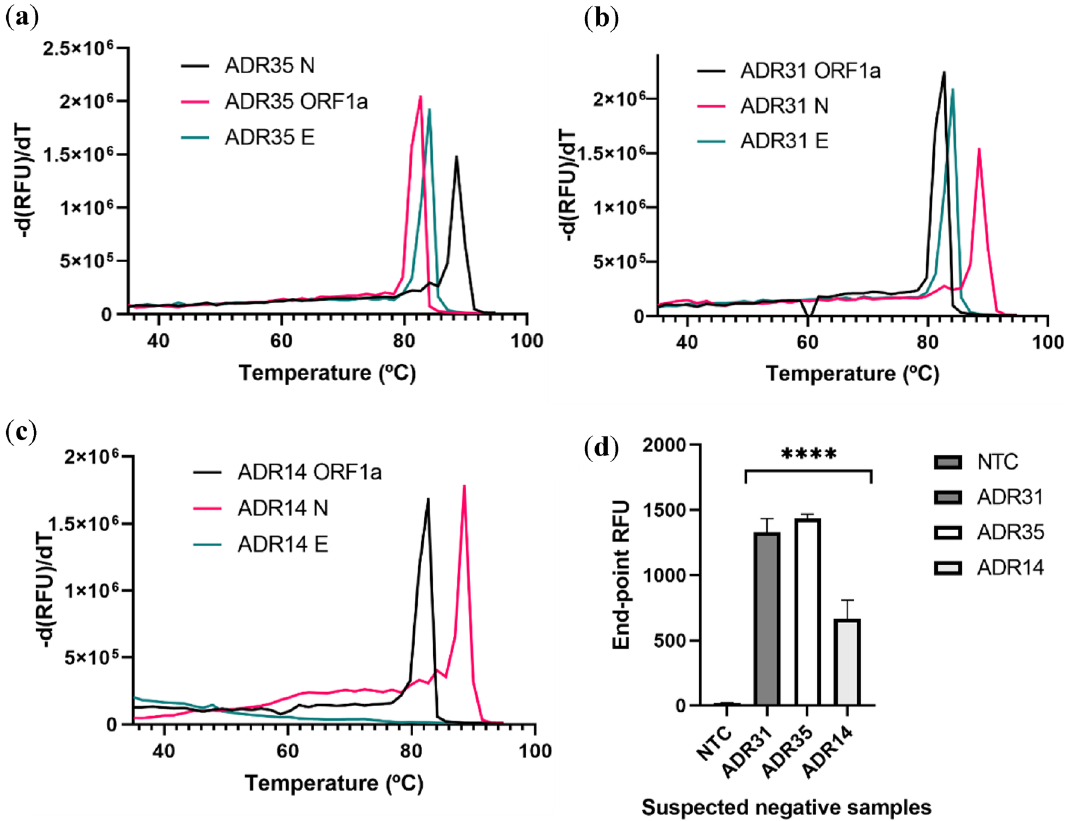
Figure 6. Melting curve analysis from the RT-LAMP reaction of clinical samples. Samples that were considered SARS-CoV-2 positive by INSA were further analysed. Melting curve for sample ADR35 ( a ), ADR31 ( b ) and ADR14 ( c ) using the primers sets for the 3 different genes. ( d ) End-point fluorescent signal measured in the Cas12a reaction. Statistical significance was determined by unpaired two-tailed t-test and all data were shown as mean ± S.D of 3 replicates. Asterisks indicate **P < 0.01; ***P < 0.001; ****P < 0.0001 and “ns” is